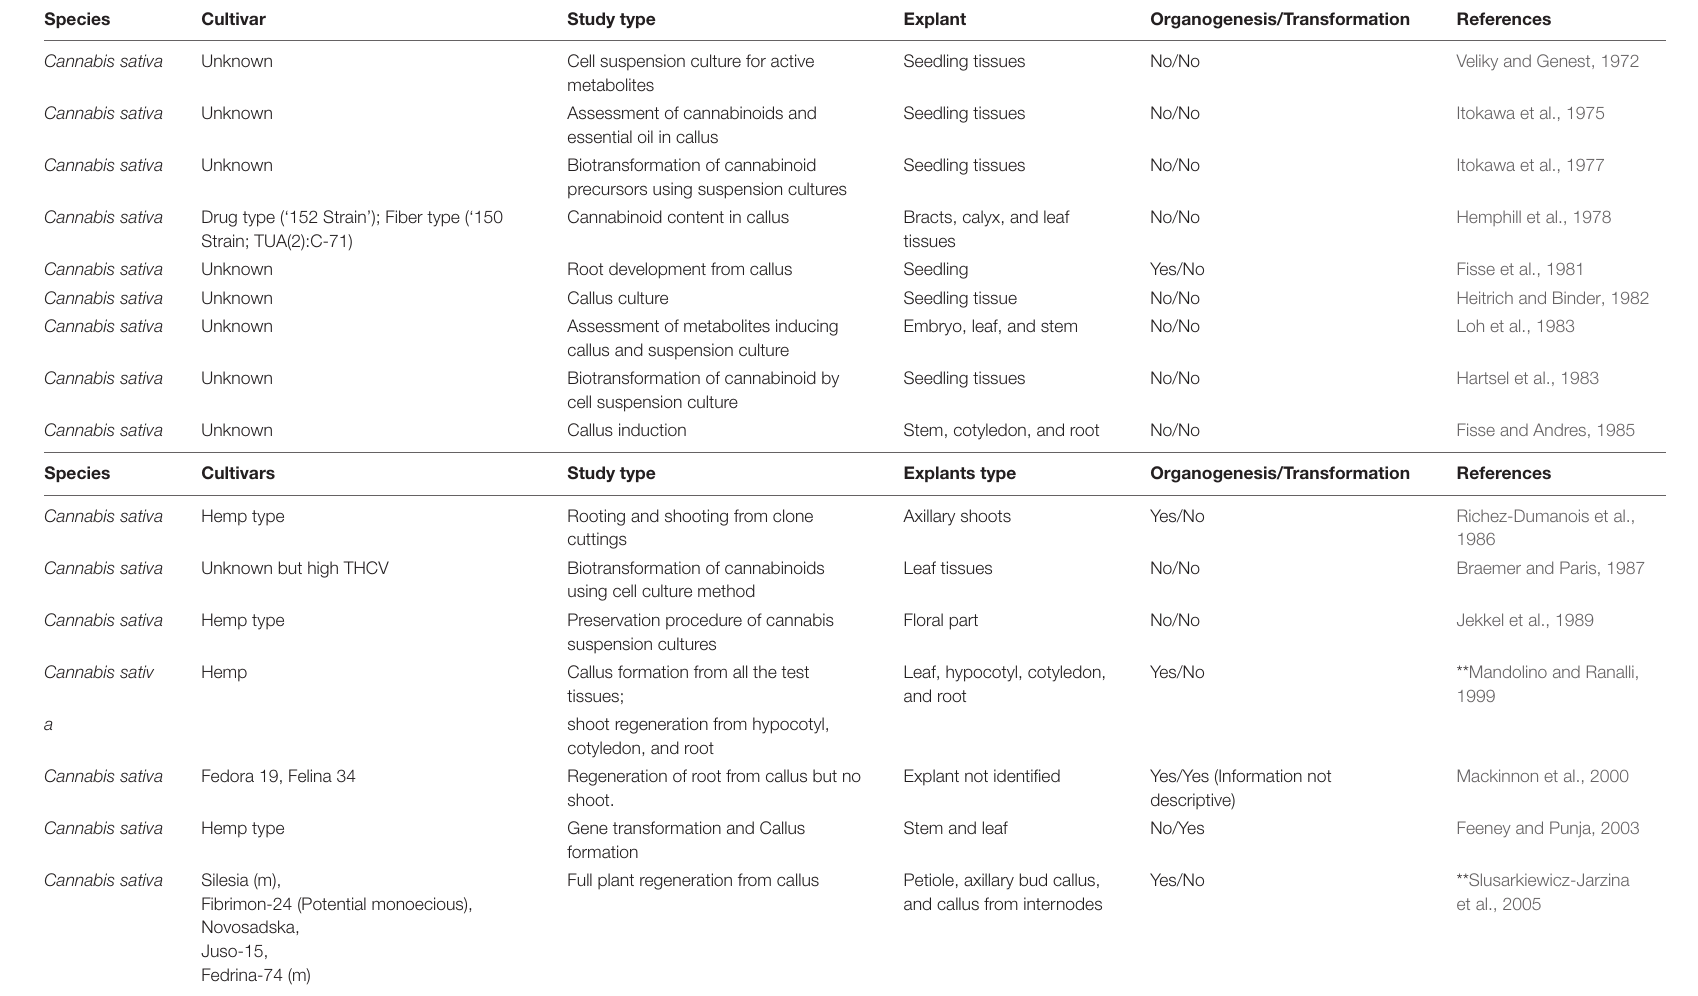
TABLE 3 | Cannabis cell culture, transformation, and micropropagation work since